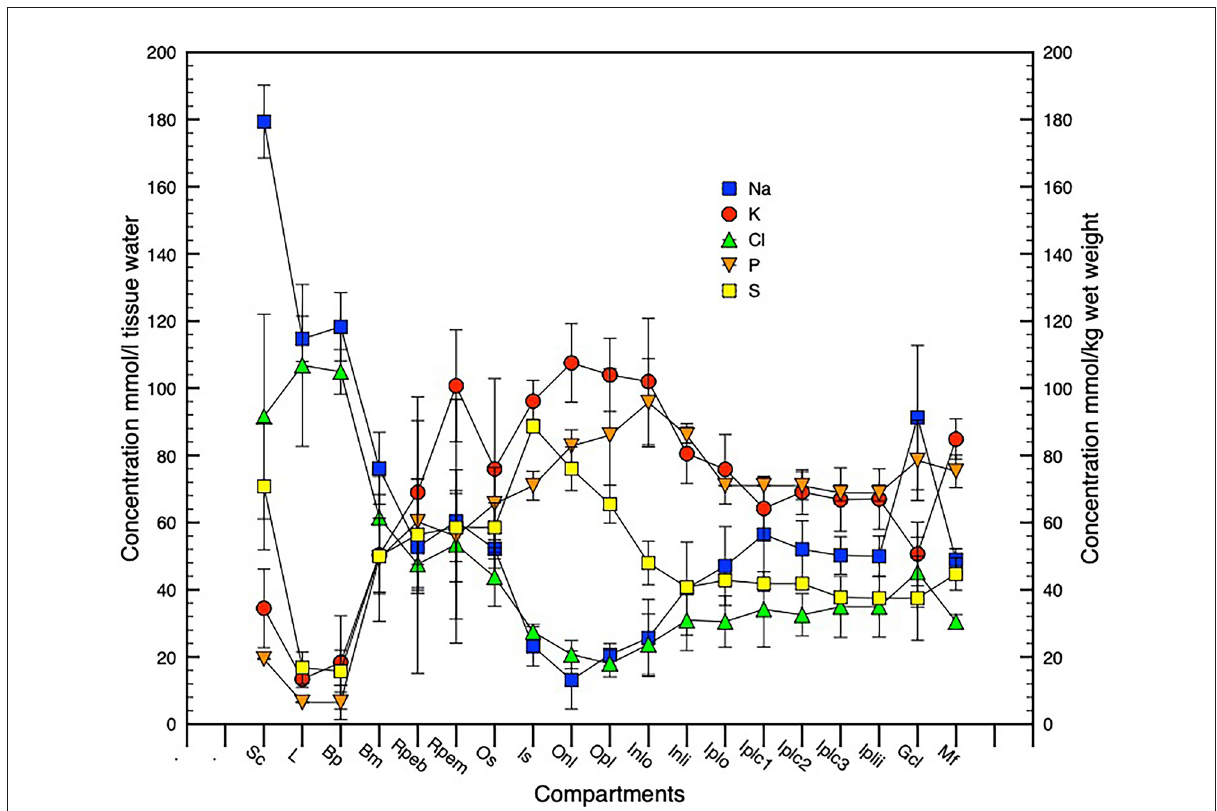
FIGURE6 Graphical presentation of element concentrations across the retinal complex. N = 3, SD error bars. Na, K, Cl expressed in mmol l − 1 cell or tissue water and P, S expressed in mmol kg − 1 wet cell or tissue mass. Compartment abbreviations on X-axis as in Figure 3A